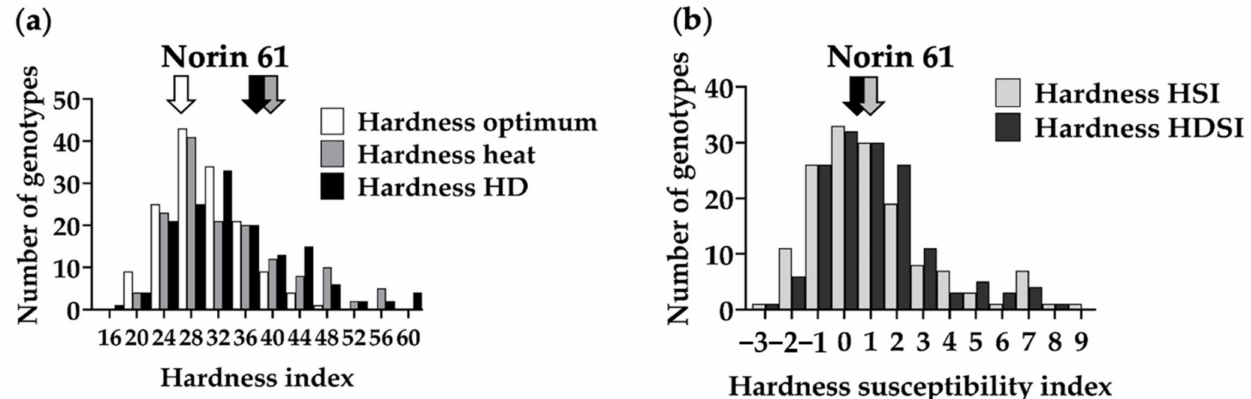
Figure 1. Frequency distribution of hardness and hardness indexes ( a ) Frequency distribution of hardness under optimum, heat and combined heat-drought (HD) environment and ( b ) Frequency distribution of hardness heat susceptibility index ( HSI ) and heat-drought susceptibility index ( HDSI ). ‘Norin 61’ is the background parent of the multiple synthetic derivative (MSD)